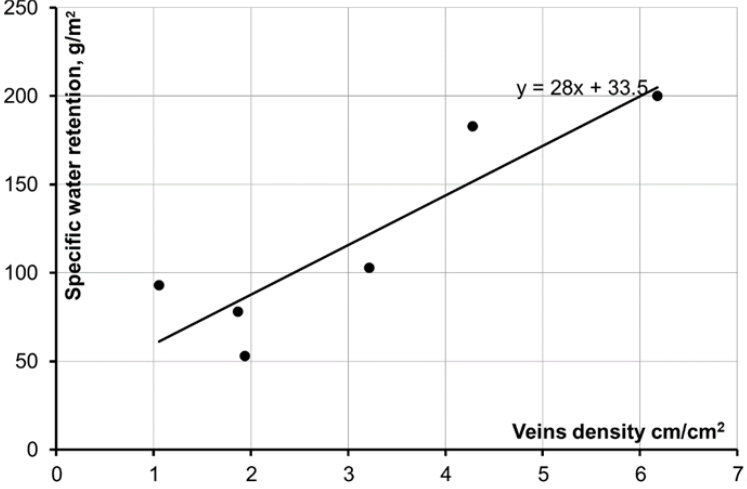
Figure 3. Dependency of specific water retention on the leaf surface of deciduous species on the density of veins of a “normal” leaf in the analyzed sample.